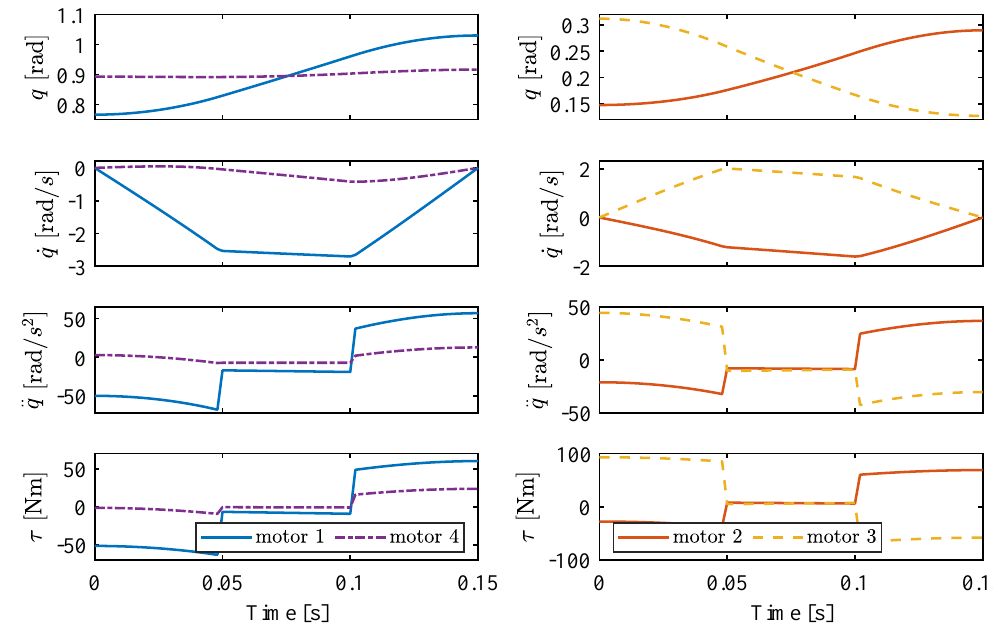
Figure 7. Example trajectory ( φ = 0.00 rad , d = 0.325 m , θ = π /3 rad , and z = − 1.00 m ): position, velocity, acceleration, and torque of the actuated joints. Table 5. Minimum and maximum energy solutions for Case (2). ∗ Energy reduction w.r.t. E max